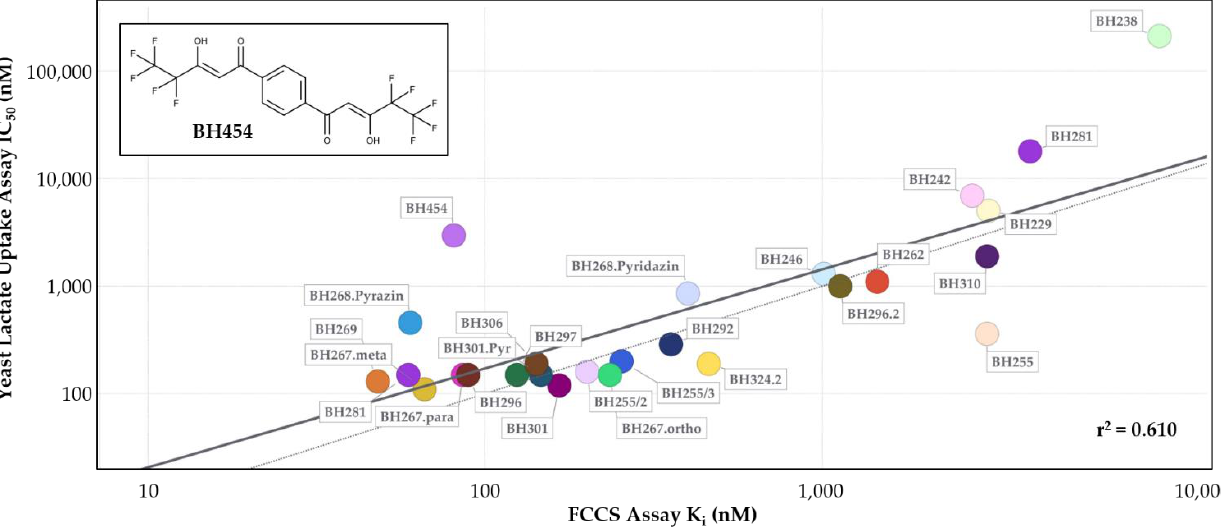
Figure 6. Scatter plot of FCCS-derived K i values vs. IC 50 -values from the yeast lactate uptake assay. The activity of 26 compounds on the uptake of lactate in the yeast assay (y-axis) was plotted against the K i values obtained from FCCS competition assays using the PfFNT-GFP and BH296-DY647 (x-axis). The diagonal is displayed as a thin dotted line, and regression is shown as a thick black line, r 2 : 0.610.